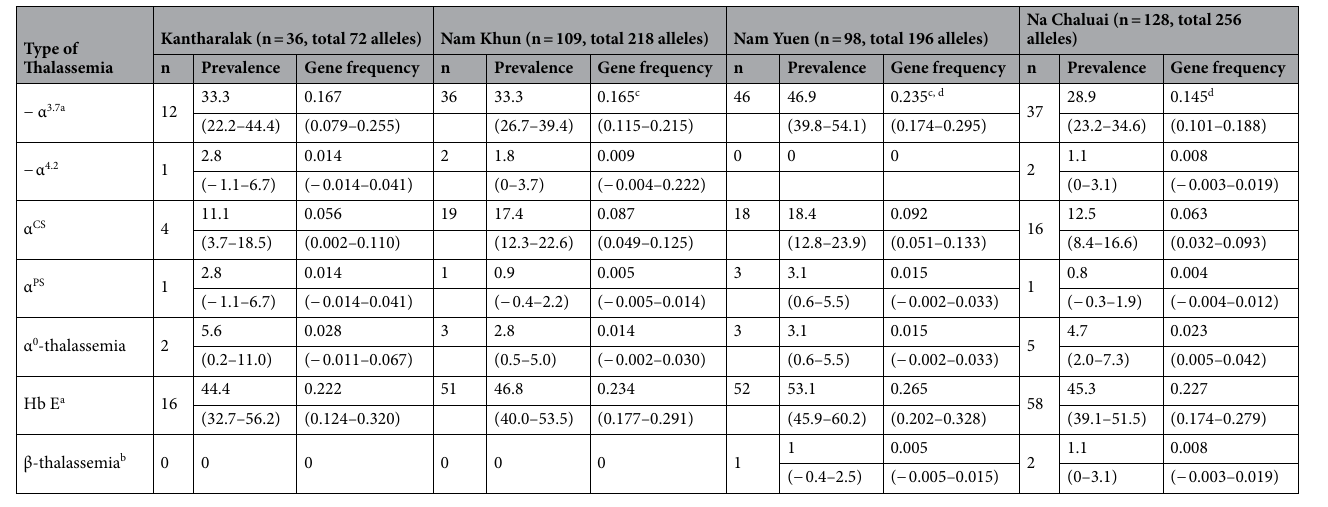
Table 2. Prevalence and gene frequency of thalassemia found among 371 subjects inhabiting at the border region of Thailand, Lao PDR and Cambodia (95% confidence interval in parentheses). The overall prevalence of α + -thalassemia (− α 3.7 , − α 4.2 , α CS α, α PS α): 199/371 = 53.6% (95%CI: 50.0–57.3), α 0 -thalassemia: 13/371 =